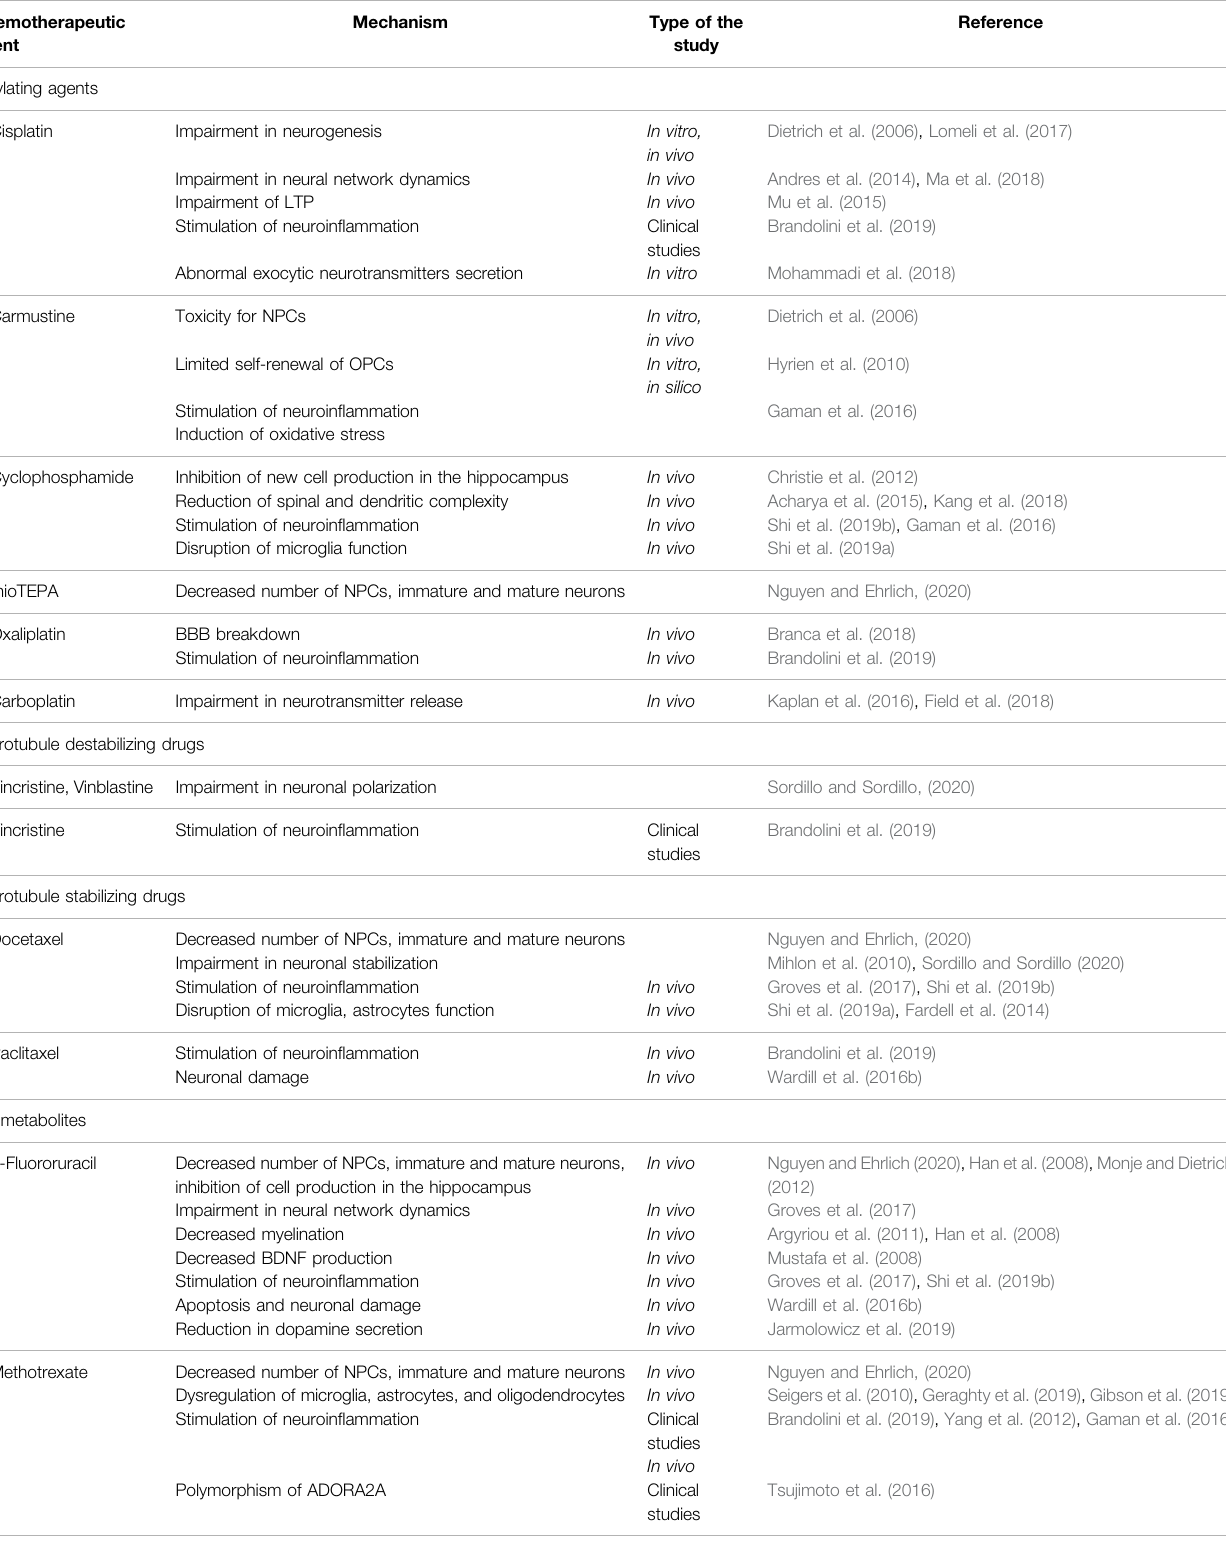
TABLE 3 | Involvement of chemotherapeutic agents on chemobrain development basing on their molecular